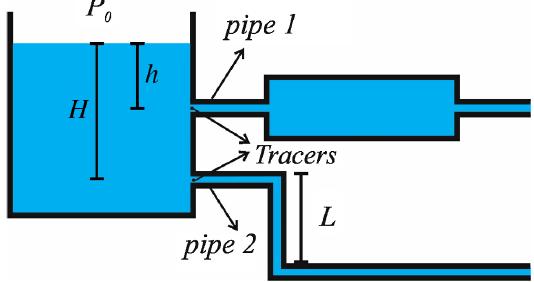
FIG. 3. Container open to the atmosphere with pressure P 0 and two draining pipes. The dimensions and the places where the tracers are released are also